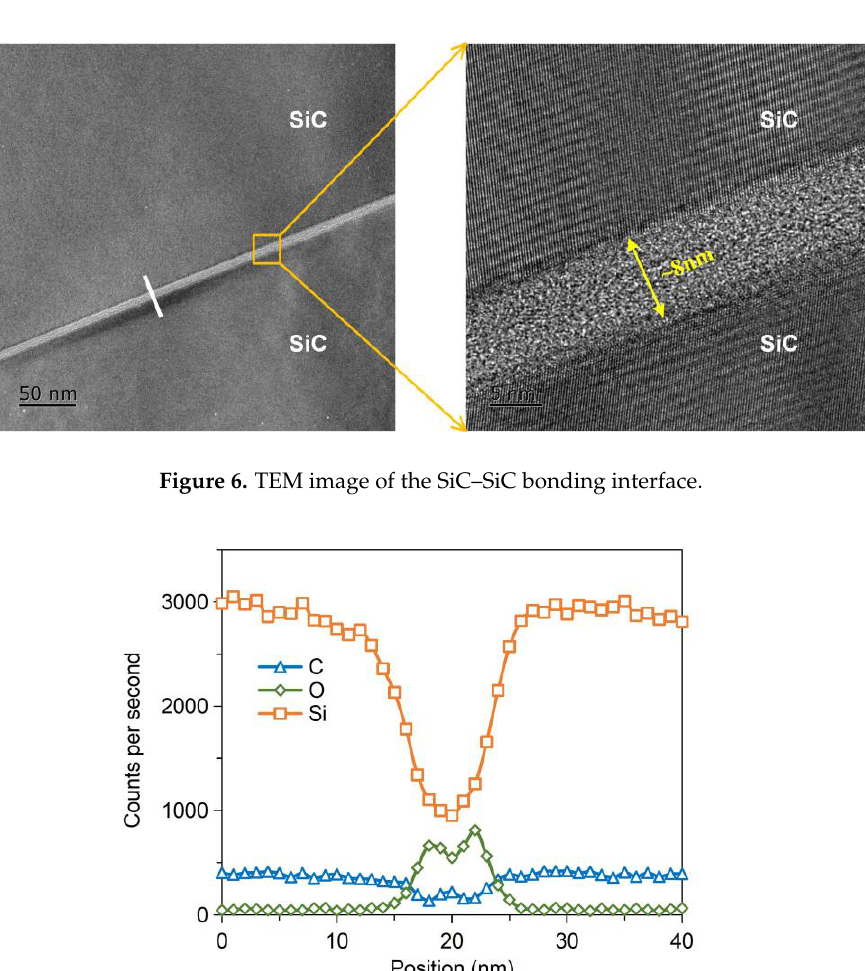
Figure 5. SEM images of the SiC cavity structure: ( a ) cross-sectional image of the bonded structure; ( b ) the magnified rectangular areas in ( a ).